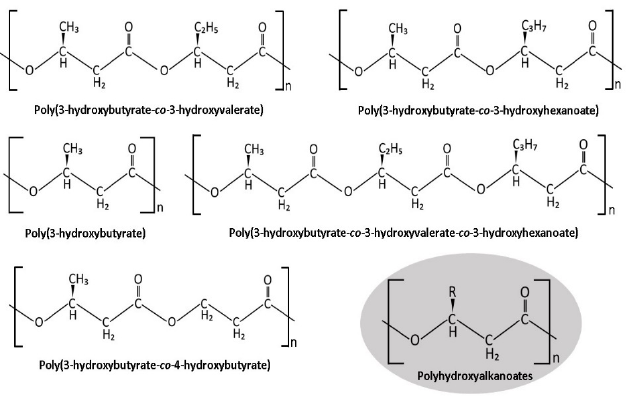
Figure 1. Chemical structures of P(3HB- co -3HV), P(3HB- co -3HHx), P(3HB), P(3HB- co -3HV- co - 3HHx), P(3HB- co -4HB), and PHA. P(3HB- co -4HB), and